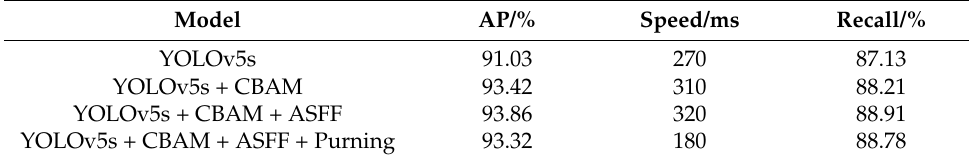
Table 1. Model Ablation Experiment.